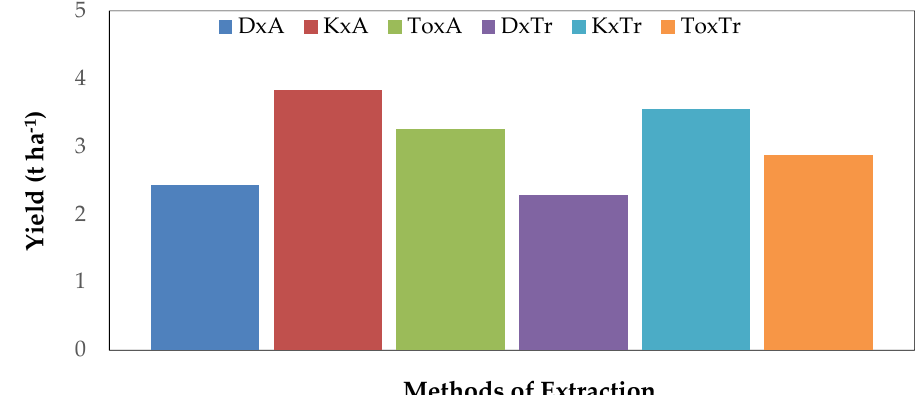
Figure 15. Interaction effect of extraction methods and jute types on fiber yield of jute. The highest labor requirement (1276 h ha − 1 ) and labor cost for jute fiber extraction and retting were found when using the traditional method. Extraction with Aashkol and retting with an improved method required 90% less labor and labor cost compared with the traditional method. Labor requirement and labor cost also varied with jute variety. Significantly lowest labor requirement (657 h ha − 1 ) was recorded for tossa jute extraction and retting. Deshi and kenaf jute required a similar amount of labor for retting and extraction of fiber. The interaction effect of jute extraction methods and the variety on labor requirements for jute extraction and retting varied significantly (Figure 16). The lowest labor requirement was recorded for using the Aashkol, irrespective of jute variety. The lowest labor requirement was recorded for kenaf jute. The interaction effect of jute extraction methods and the variety on labor costs also varied significantly (Figure 16). The highest labor cost was required in the traditional method with deshi and kenaf jute, and the lowest labor cost was required in the improved method with Aashkol irrespective of jute variety.